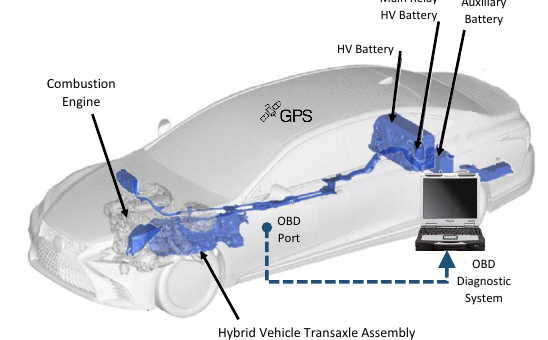
Fig. 4. A scheme of Lexus Hybrid Drive System along with the applied measuring devices (based on [14])